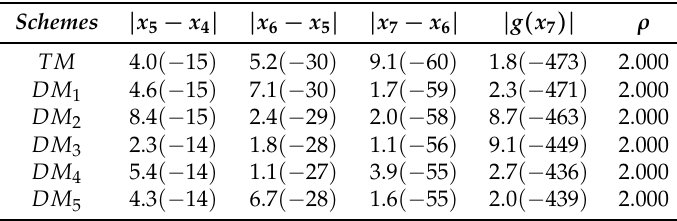
Table 5. Numerical results of Example